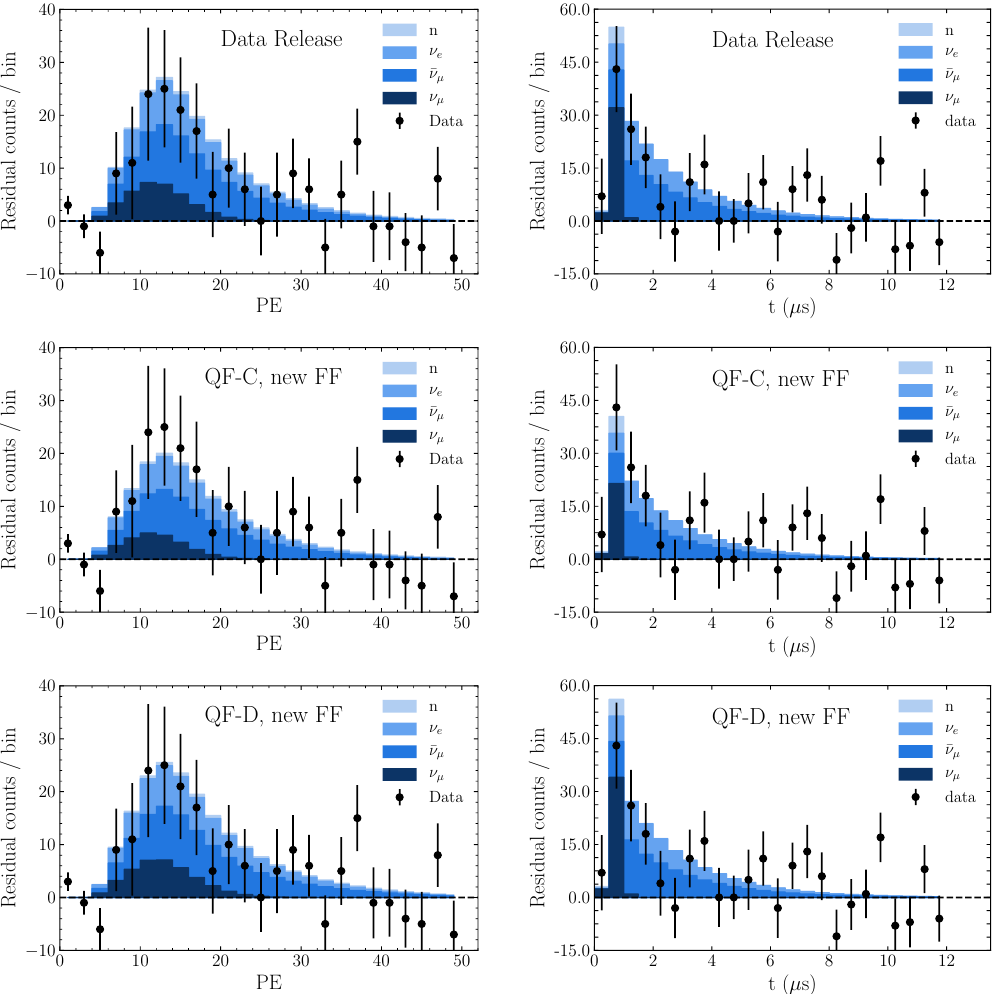
Figure 2 . Residual events per bin obtained after subtracting C and AC data for the beam-ON sample, after being projected onto the PE (left panels) and time (right panels) axes and using the same cuts in PE an time as those applied to (cid:12)gure 3 in ref. [35]. The observed data points are indicated with statistical error bars, as in ref. [35]. In the upper panels the shaded histograms show the predicted event rates in the SM using the QF and nuclear FF from ref. [36]. In the middle panels they correspond to the predictions with the QF from the Chicago group (QF-C) in ref. [58] and the nuclear FF from ref. [48, 49]. The lower panels have been obtained with the same FF, but changing the QF to match the Duke (TUNL) measurements in ref. [35] (QF-D). In all panels the prompt neutron background prediction is also shown for completeness. All the event histograms shown in this (cid:12)gure correspond to the SM